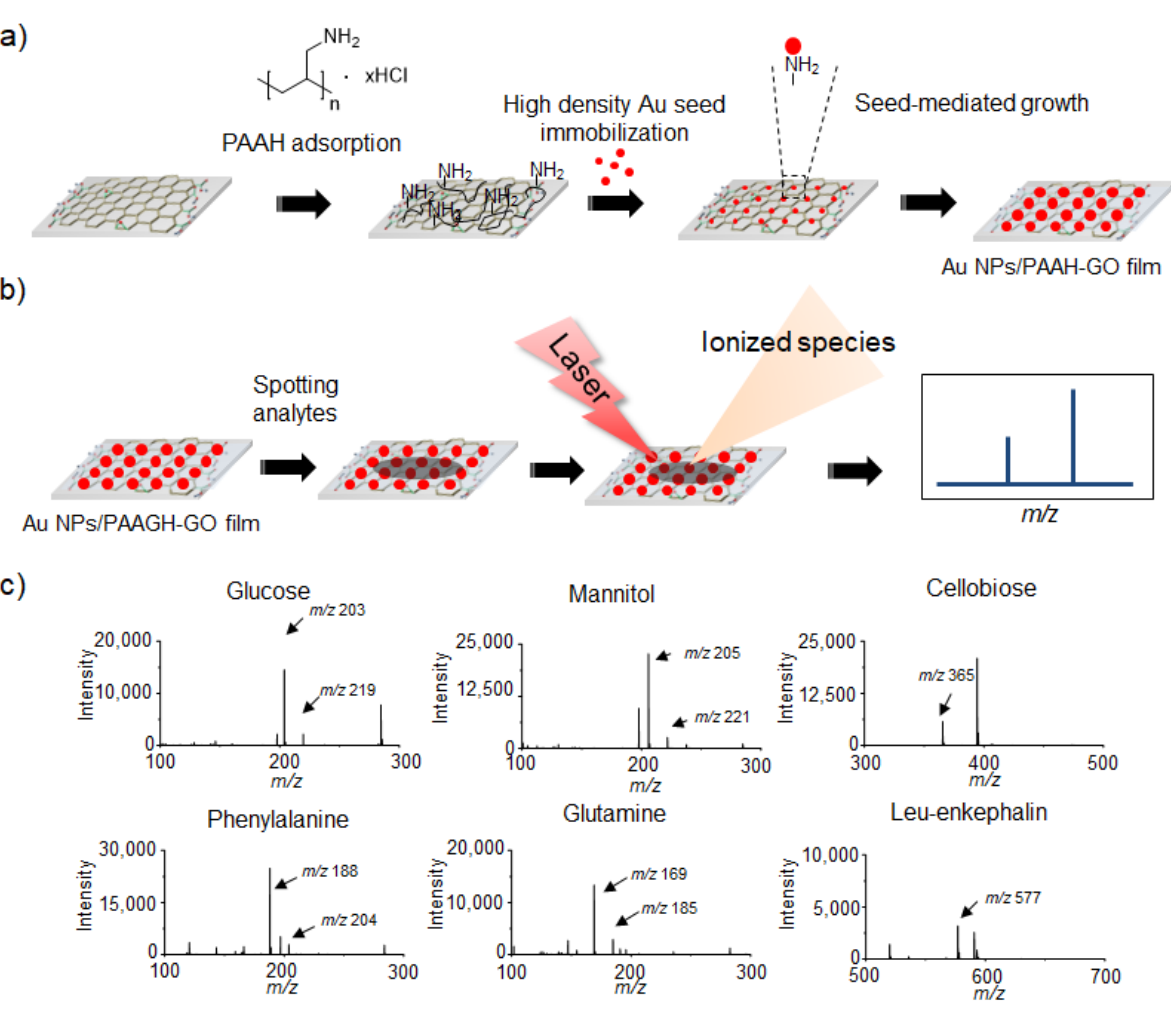
Figure 6. ( a ) Preparation process of Au NPs/PAAH-GO films and ( b ) LDI-TOF-MS analysis process of small molecules on Au NPs/PAAH-GO films. ( c ) LDI-TOF-MS spectra of small molecules such as glucose, mannitol, cellobiose, phenylalanine, glutamine and Leu-enkephalin obtained on Au NPs/PAAH-GO films. Adapted with permission from ref. [82]. Copyright 2012 American Chemical Society.